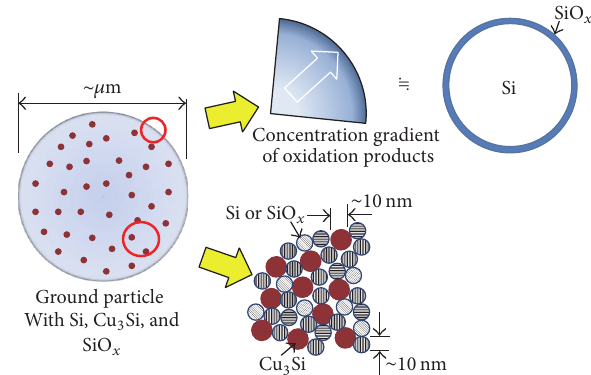
Figure 12: Schematic illustration of the composite formed by grinding Si, H 2 O, and Cu. The composite can be modelled as an aggregate of Si, Cu 3 Si nanoscale grains, and Si oxidation products near the surface, similar to a Si particle covered with a Si oxide film.